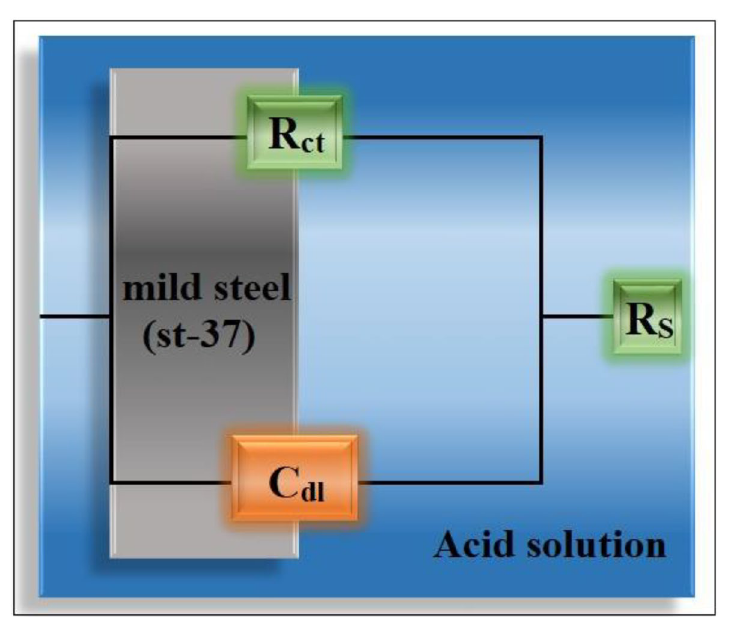
Figure 5. The electrical equivalent Randle’s circuit